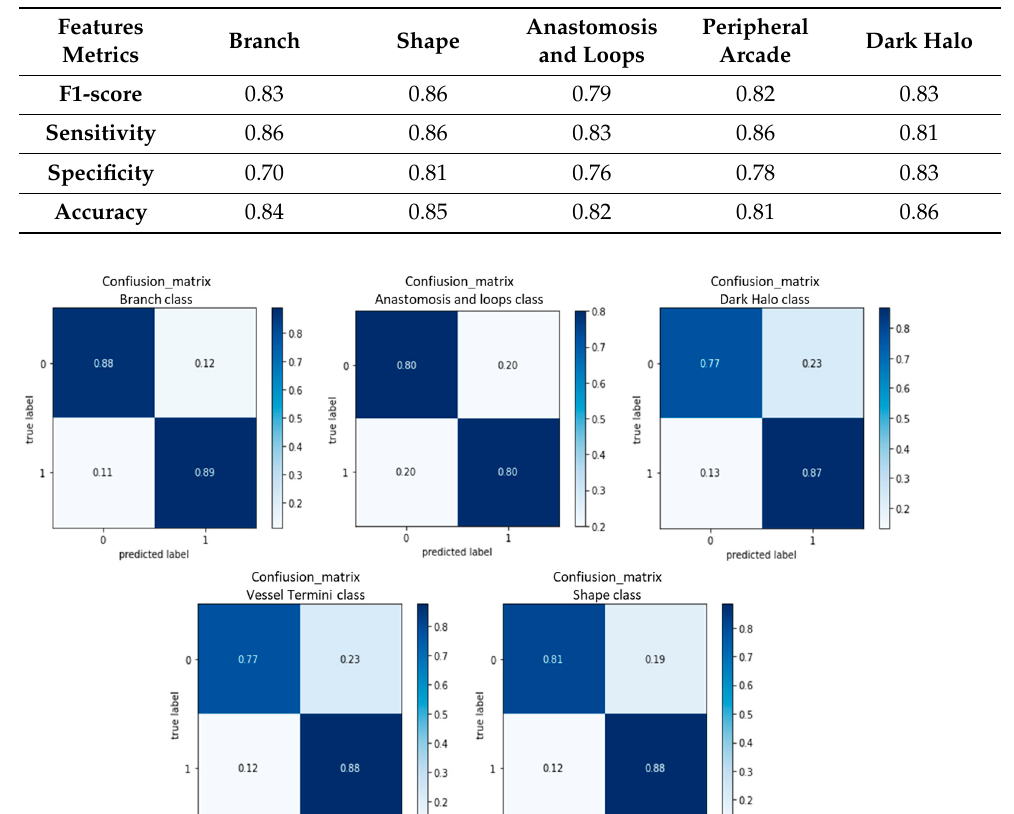
Table 3. Classification metrics for five classifier models.